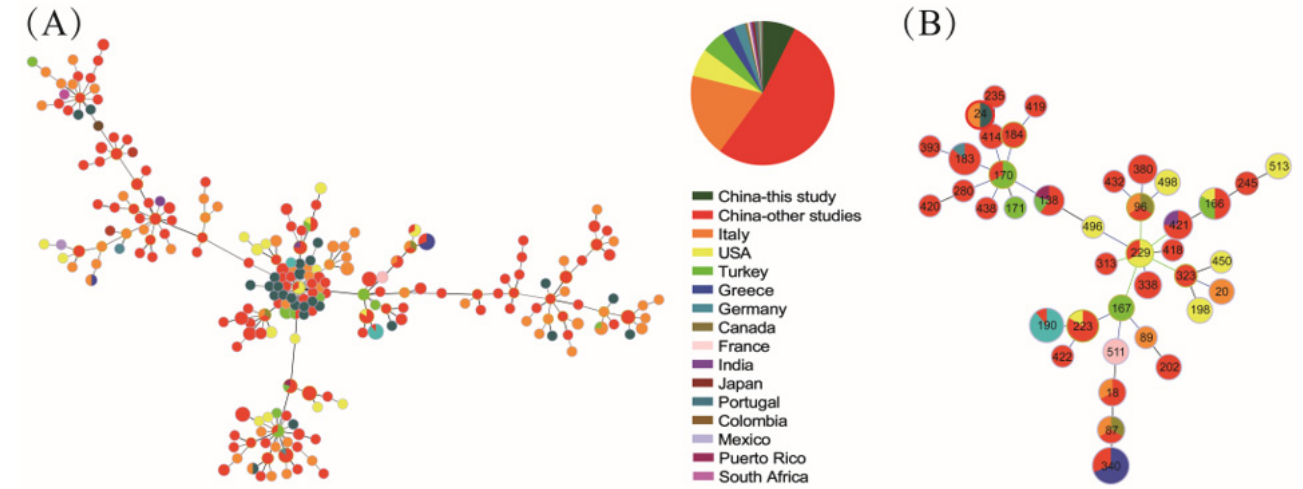
Figure 3. The goeBURST analysis based on the four loci used for MLST typing: ( A ) the full minimum spanning tree generated by 223 STs (including the 25 STs identified in this study) from pubMLST database for Vibrio spp. Isolates from different countries are represented by different colors. Node sizes are proportional to the number of isolates; ( B ) clonal complex 0 of 40 STs. STs are marked inside the circle. The ST 24 identified in this study is marked by red circle.